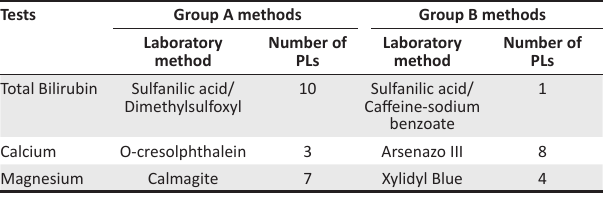
TABLE 1: Clinical chemistry tests with two different methods used in Togo from July 2016 to December 2016 .